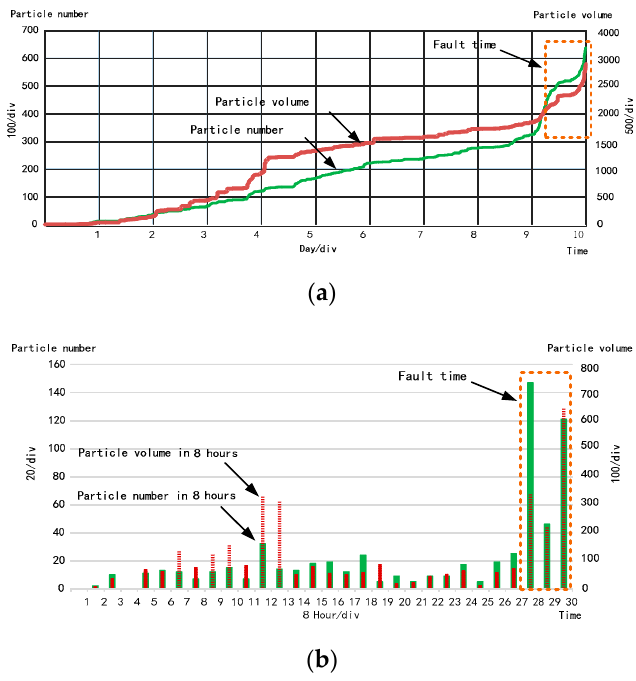
Figure 12. Record data of the abrasive particles within 10 days before the faults. ( a ) Line diagram showing the increase in the quantity and volume of the abrasive particles. ( b ) Bar chart showing the increase in the quantity and volume of the abrasive particles in every 8 h.